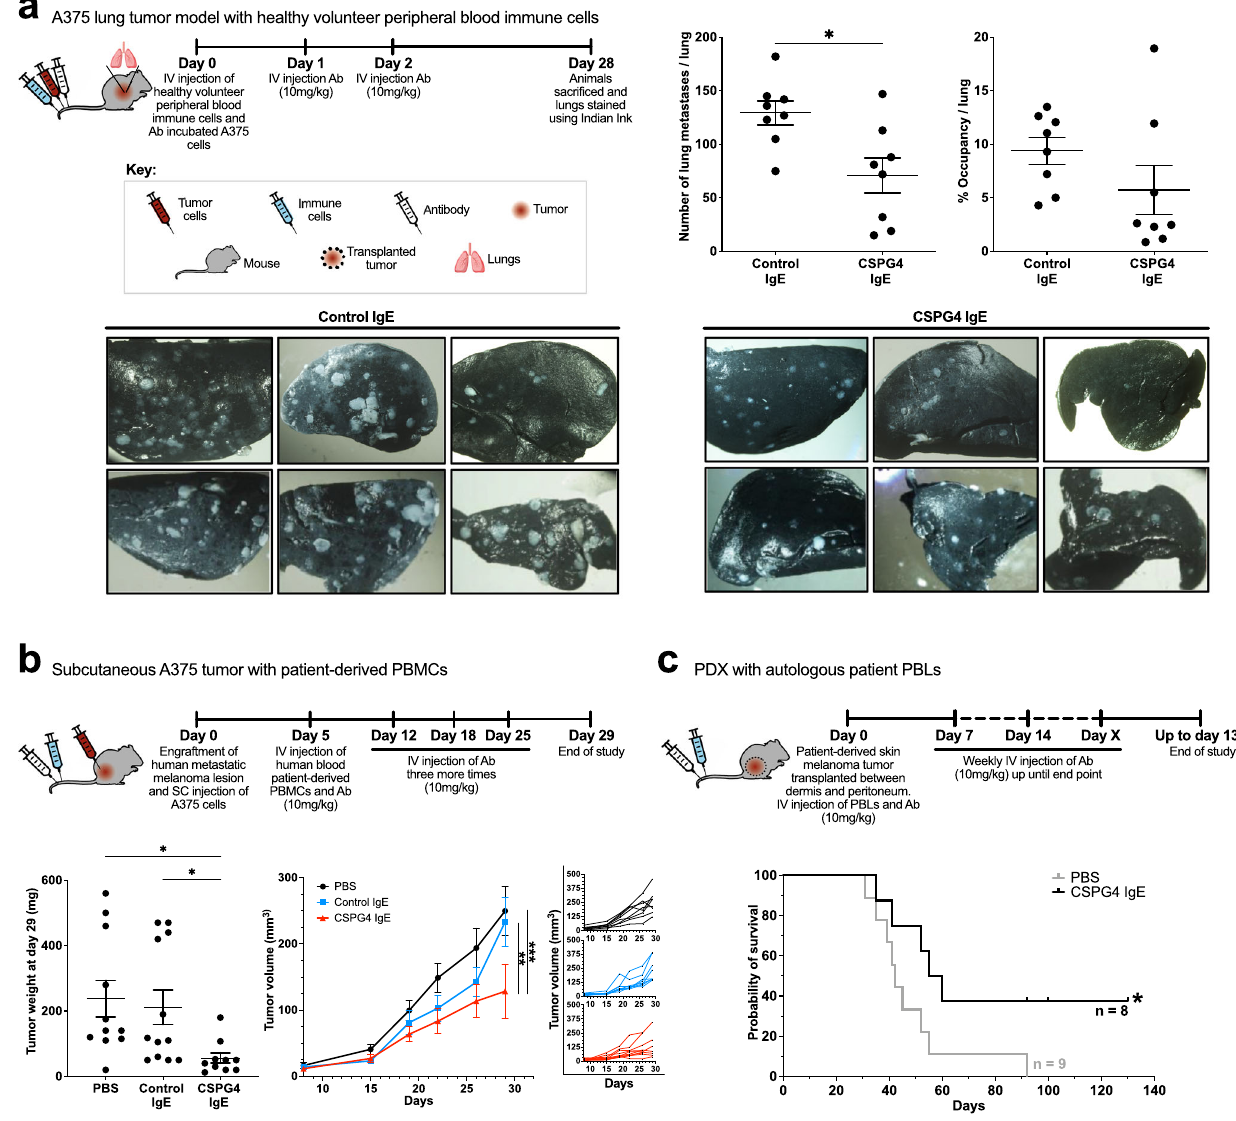
Fig.7|Ef fi cacyofCSPG4IgEinA375andPDXtumormodels.a Upperleft:Design anddosingregimenforinvivomodel.IV=intravenous,Ab=antibody.Upperright: In an A375 human melanoma model of lung metastases, engrafted with healthy volunteerperipheralbloodimmunecells,thenumberofmetastasesperlung( n =8; p =0.0107),and%occupancybytumormetastasesperlung( n =8)werereducedin CSPG4 IgE-treated animals, compared to those treated with a non-speci fi c isotype controlIgE(ControlIgE).Lower:Representative images ofIndian ink-stained lungs showingtumormetastasesinwhite. b Upper:Designanddosingregimenforinvivo model. SC=subcutaneous. Lower left: In an A375 subcutaneous model engrafted with melanoma patient-derived PBMCs, mice treated with CSPG4 IgE had sig- ni fi cantly lower tumor weights at the end of the study, compared to those treated with Control IgE ( n =11, n =12, n =10) ( p =0.0243 and p =0.0408). Lower right: In the same model, tumor volume was signi fi cantly lower in animals treated with